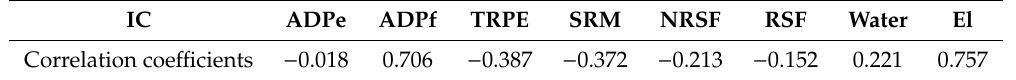
Table 4. Correlation of GWP with Consumption